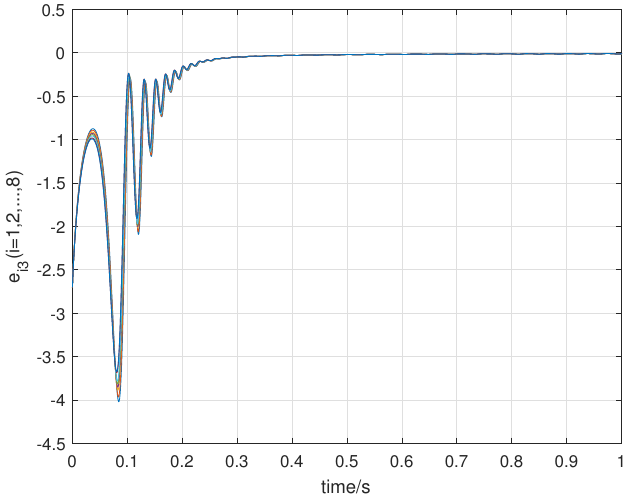
Figure 4. Trajectories of synchronization errors e j 3 ( 1 ≤ j ≤ 8 ) for the complex networks (70) and (73) with eight fractional order nodes with time variance.